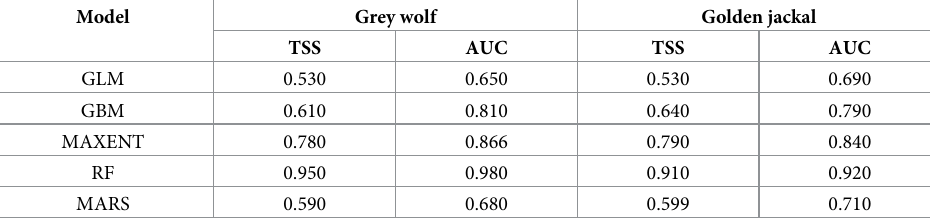
Table 1. Accuracy evaluation of the different models’ models (TSS, AUC) used to predict distribution of grey wolf and golden jackal in central Iran. Republished from [http://www.frw.ir] under a CC BY license, with